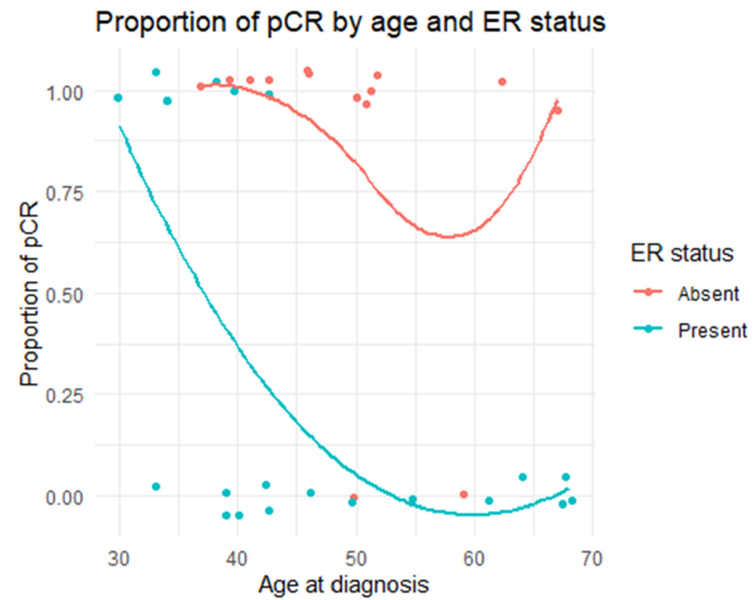
Figure 1. Relationship between achieving a pathologic complete response, the ER status, and patient